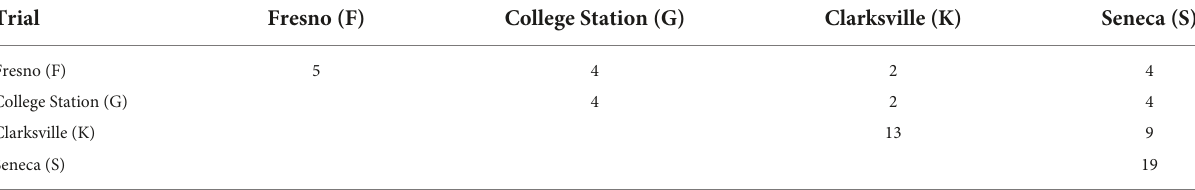
TABLE 1B Number of defined unique joint genotypes, across a 2-Mb interval encompassing a large-effect QTL for SSC on chromosome 4 of peach, within and common across peach/nectarine germplasms evaluated at the four trials.